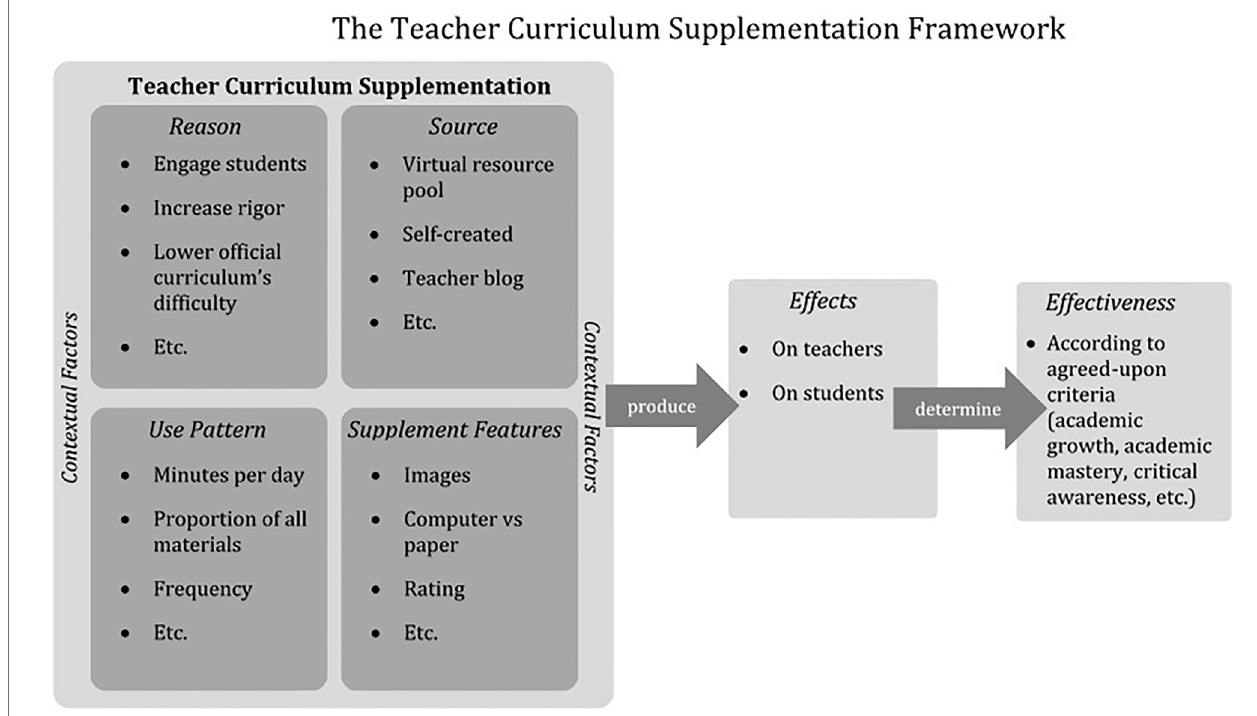
FIGURE 1 | The Teacher Curriculum Supplementation Framework (Silver, in